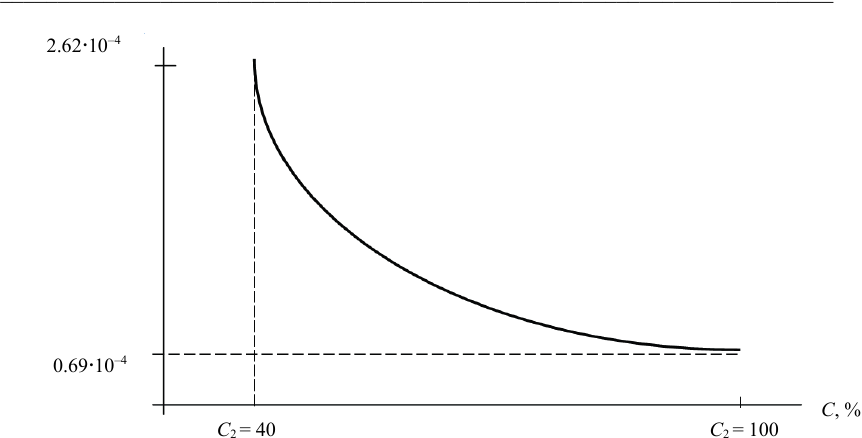
Fig. 3. Graph of the distribution of the removed foreign impurities and dust along the height of the perforated wall of the